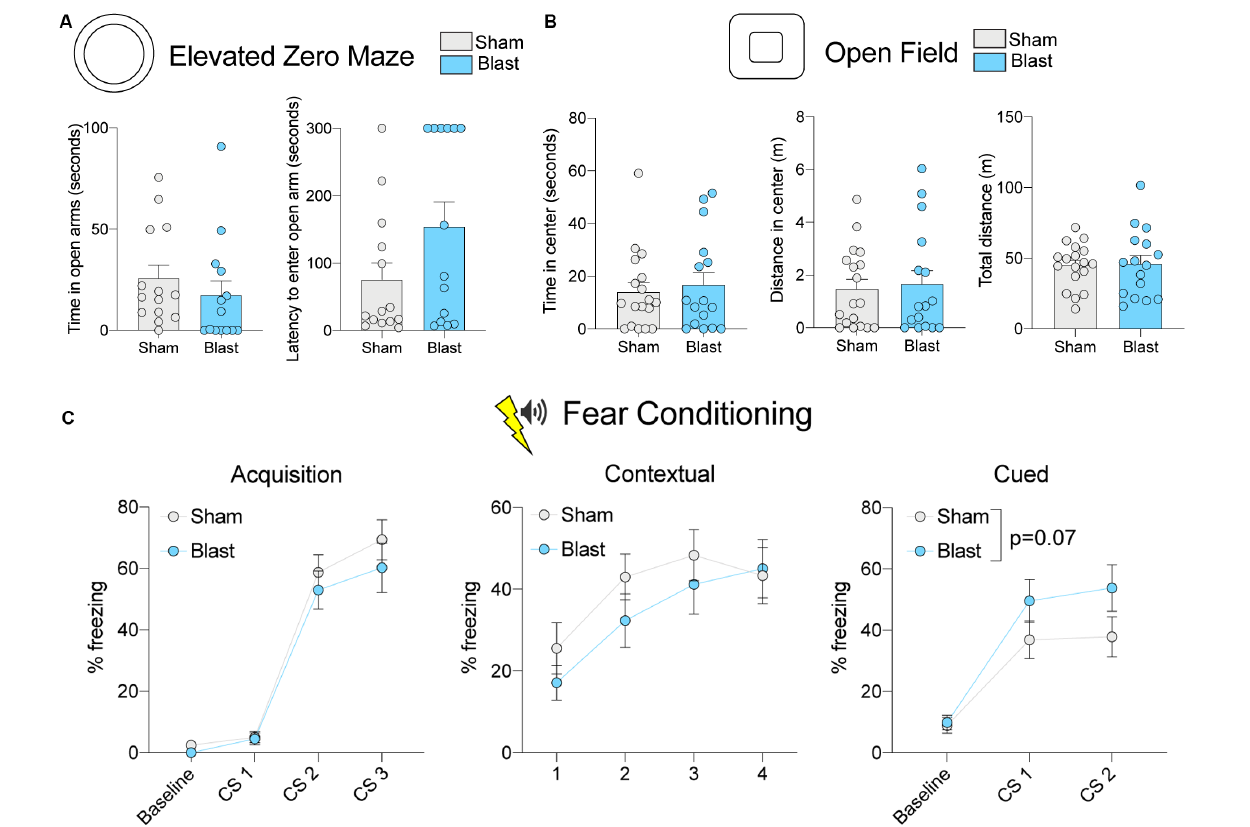
FIGURE 3 | Behavioral testing results for the chronic cohort. (A) Time spent in open arms and latency to enter open arms for the EZM. (B) Time spent in the center, distance traveled in the center, and total distance traveled in the OFT. (C) Percent freezing levels during acquisition, contextual fear testing, and cued fear testing. P -value corresponds to the main effect of blast treatment (error bars represent